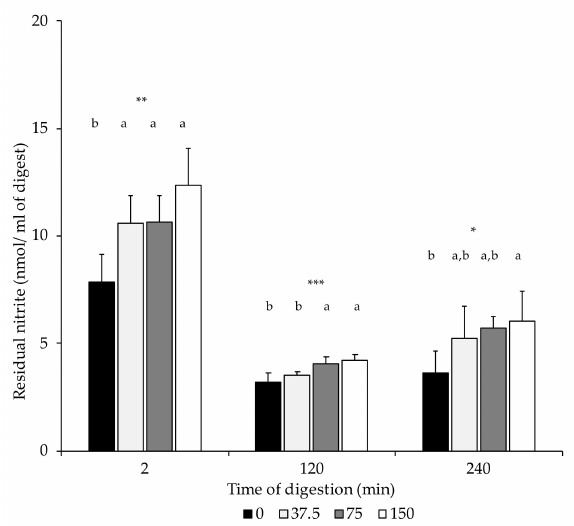
Figure 2. Nitrite content (nmol/mL of digest) in digest at the end of the oral (2 min), gastric (120 min), and intestinal phase (240 min). n.s.: not significant; *: p ≤ 0.05; **: p ≤ 0.01; ***: p ≤ 0.001. a,b: Values for the same time of sampling bearing different letters are significantly different at p ≤ 0.05, Tukey’s